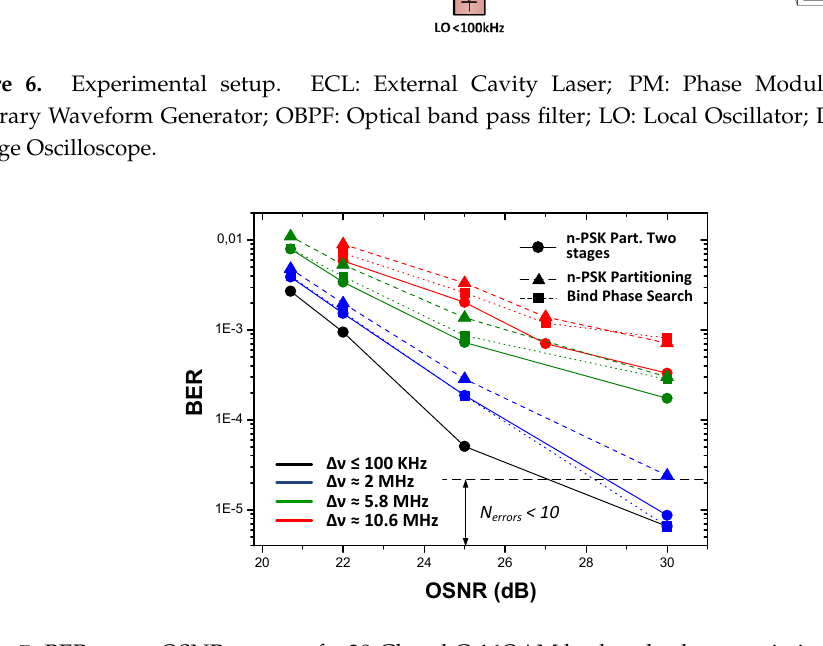
Figure 8. Two different implementation approaches of the symbol decision circuit corresponding to the best- and worst-case scenarios in terms of computational complexity. ( a ) Decision based on I and Q levels comparison. ( b ) Decision based on distance calculation to all the points in the constellation.